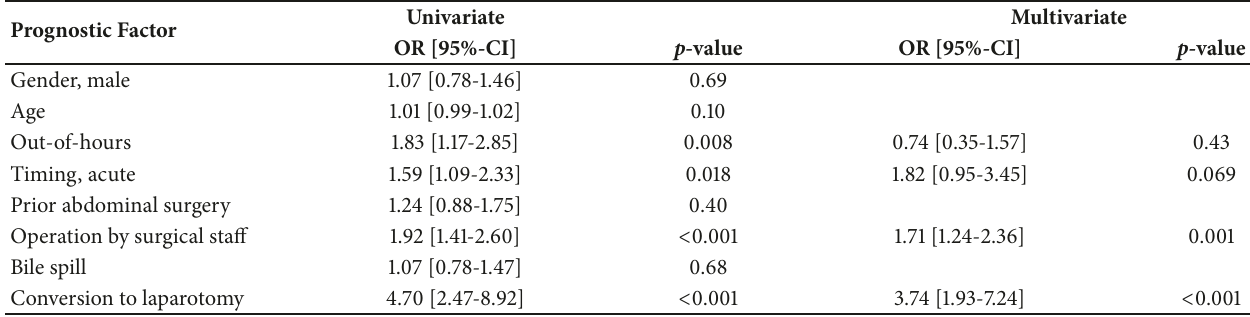
Table 5: Uni- and multivariate analyses assessing the association between different factors and postoperative morbidity after laparoscopic